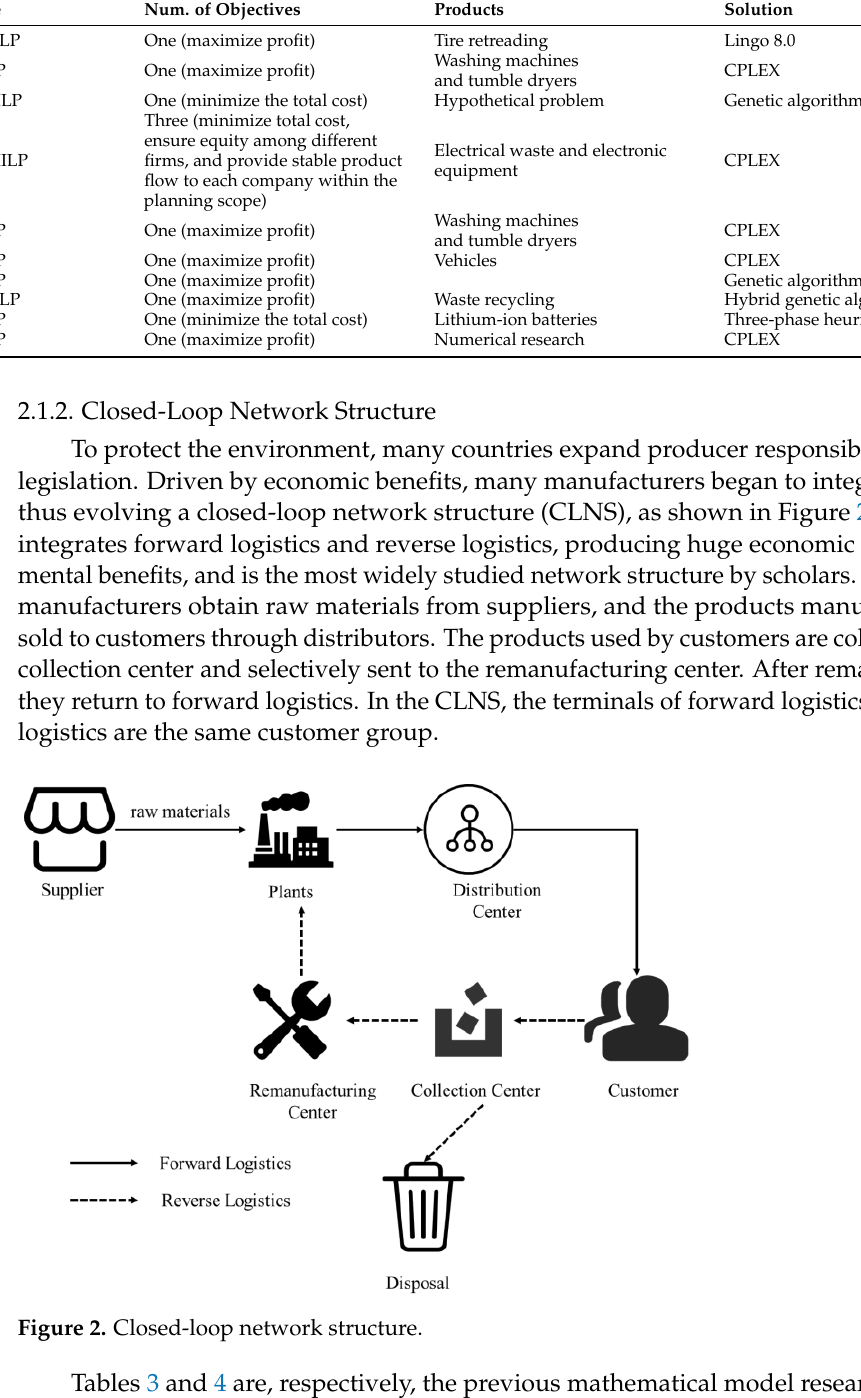
Table 2. Mathematical model of general network structure.